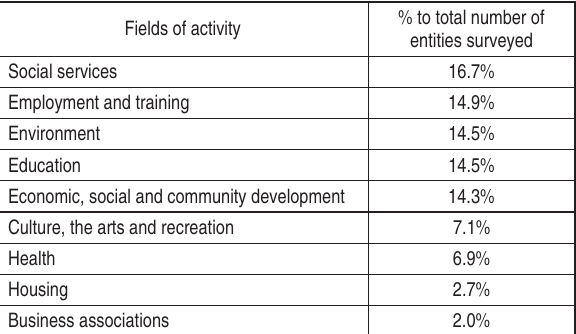
Table 1. The fields of activity of social